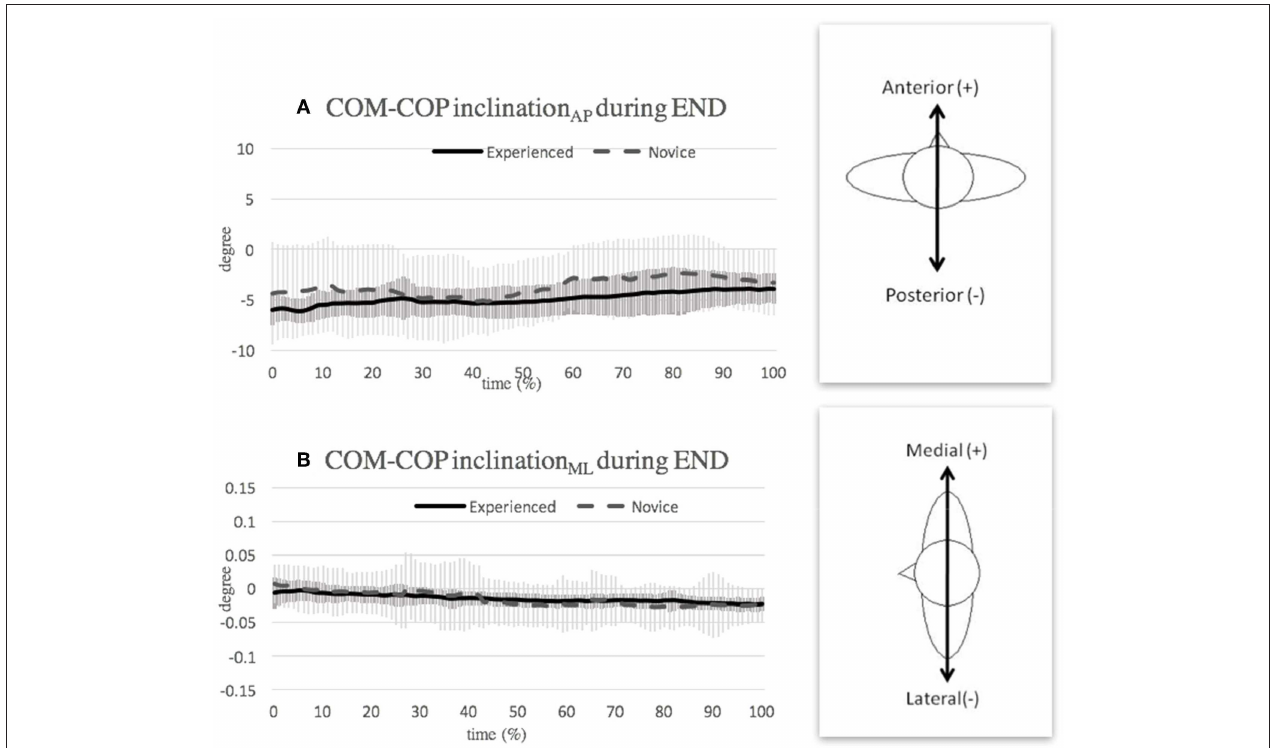
FIGURE 7 | Mean and SD of COM-COP inclination angle in (A) anterior-posterior direction and (B) medial-lateral direction during ending (END) phase. Note that the curves show the average value obtained over the three highest-scoring trials of each individual in the respective